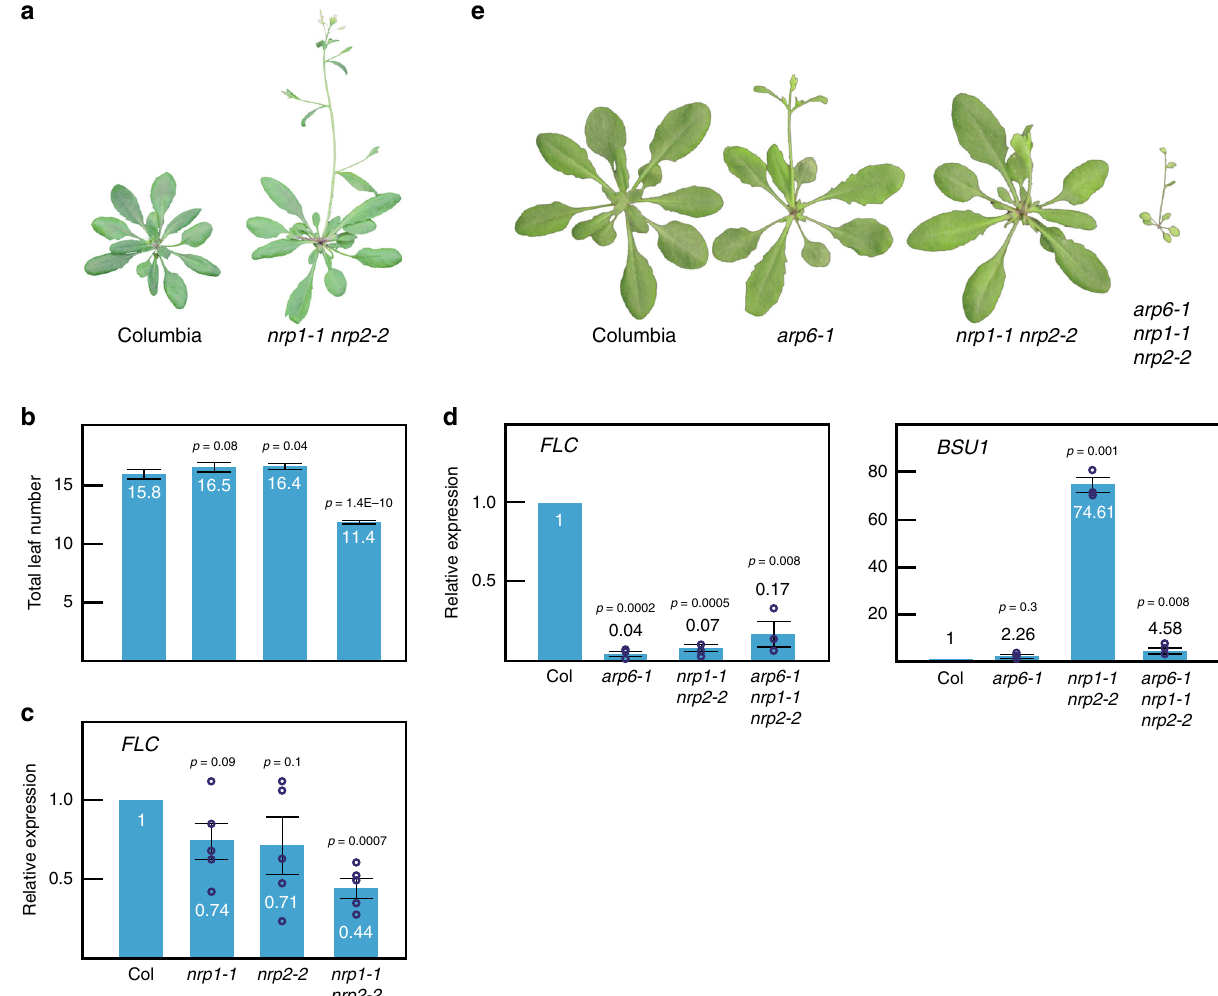
Fig. 1 The phenotype of nrp1-1 nrp2-2 double mutants. a Columbia and nrp1-1 nrp2-2 plants grown 5 weeks under long-day conditions. b Flowering time of Columbia, nrp1-1, nrp2-2 , and nrp1-1 nrp2-2 plants expressed as the total number of leaves under long-day conditions. Average from 12 ( nrp1-1 and nrp2-2 ) or 20 (Columbia and nrp1-1 nrp2-2 ) plants ± standard error (SE) is shown. c Relative expression of FLC in Columbia, nrp1-1, nrp2-2 , and nrp1-1 nrp2-2 backgrounds measured by RT-PCR. Error bars represent standard error. This experiment was repeated under the same conditions yielding similar results. d Relative expression of FLC and BSU1 in Columbia, arp6-1 , nrp1-1 nrp2-2 , and arp6-1 nrp1-1 nrp2-2 backgrounds measured by RT-PCR. Error bars represents standard deviation. UBQ10 was used as an internal control. e Morphological phenotype of 5 weeks old Columbia, arp6-1 , nrp1-1 nrp2-2 , and arp6-1 nrp1-1 nrp2- 2 plants grown under long-day conditions. b – d Two-tailed, paired Student ’ s t test was used to determine p -value. Source data underlying Fig. 1b – d are provided as a Source Data fi